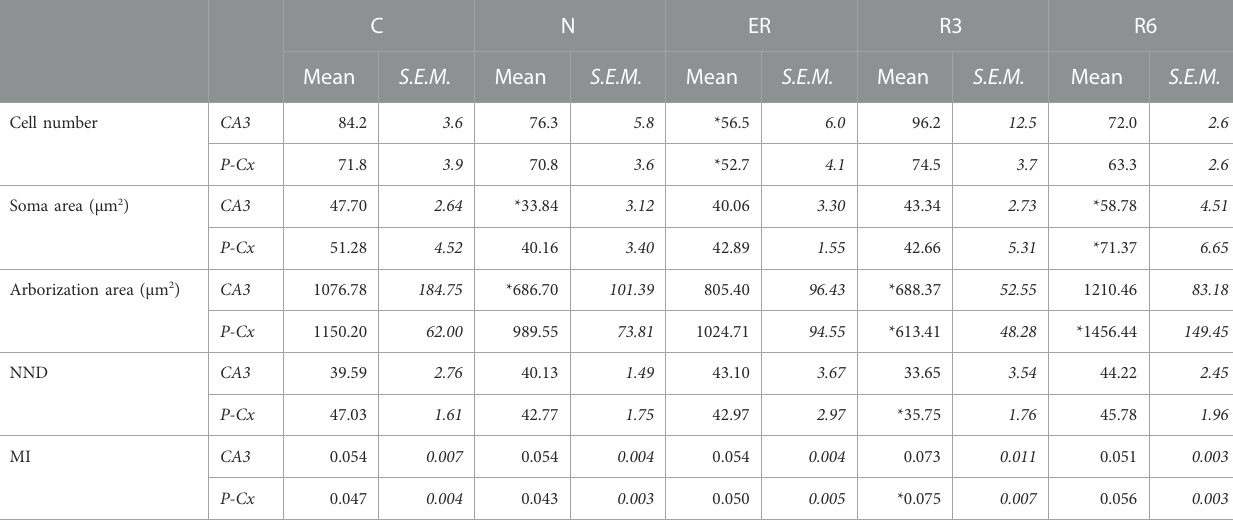
TABLE 2 Microglia morphometric